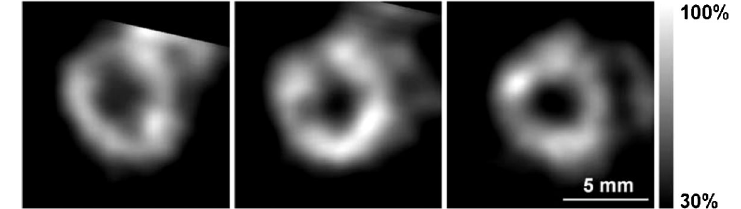
Figure 4. Cardiac images. Characteristic slices perpendicular to the main axis of the recon- structed volumetric model of the radioactive emission from the mouse heart, labeled with 99m Tc-MIBI, after 80